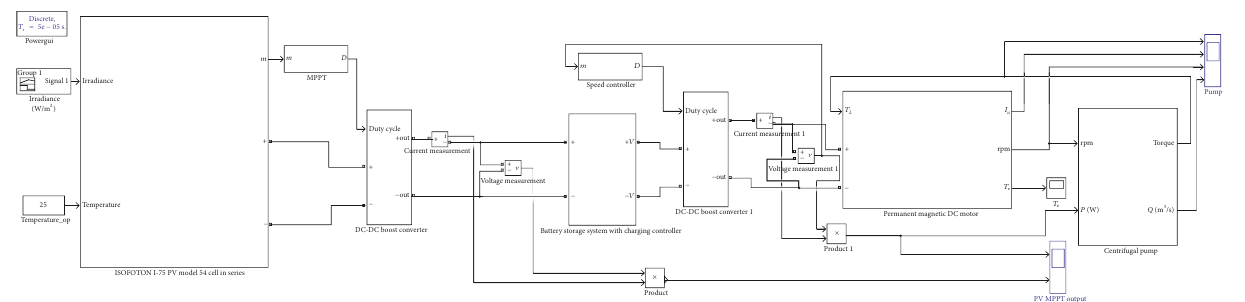
Figure 19: Battery charging controller.